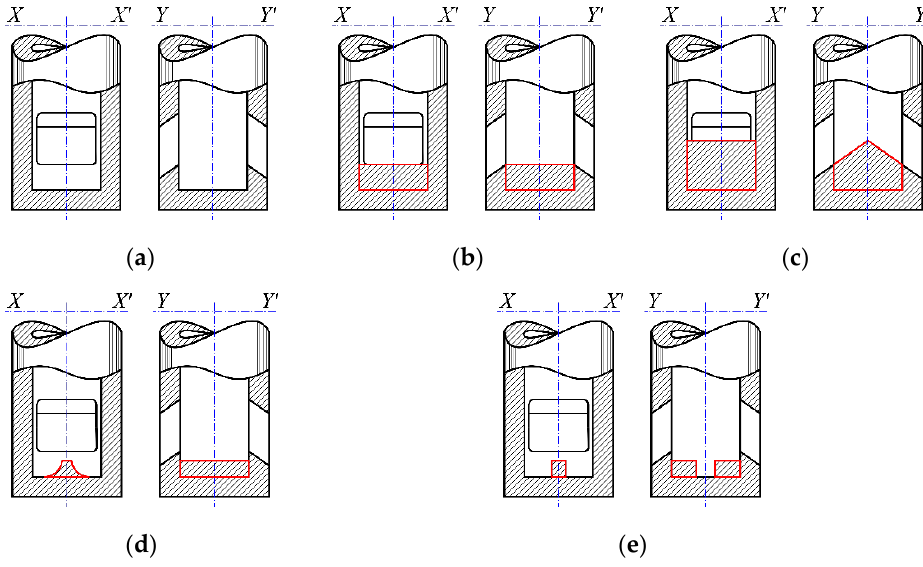
Figure 2. SEN inner geometry characteristics for the three most common designs and two specialized ones. ( a ) Well bottom, WB. ( b ) Flat bottom, FB. ( c ) Mountain bottom, MB. ( d ) WB-nozzle with a solid barrier attached at the SEN inner bottom wall [13]). ( e ) WB-nozzle with two separated solid barriers attached at the SEN inner bottom wall (adapted from [14]).